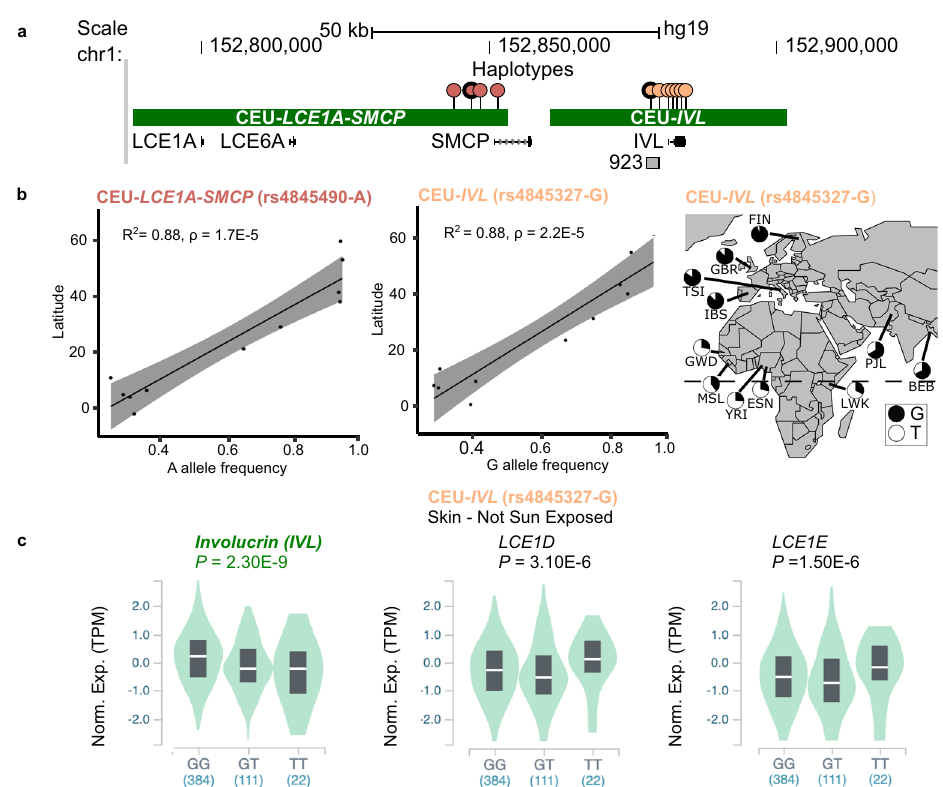
Fig. 2 Selective sweeps for CEU- LCE1A-SMCP and CEU- IVL out-of-Africa. a Phasing reveals CEU- LCE1A-SMCP and CEU- IVL haplotypes (green bars) in CEU based on SNPs in linkage disequilibrium ( r 2 > 0.8) with the high CMS/iSAFE (red; rs12022319, rs4845490 [bolded], rs4845491, & rs3737861) and iSAFE (orange; rs4845327 [bolded], rs1854779, rs7539232, rs11205132, rs2229496, rs7535306, & rs7545520) SNPs (lollipops). CEU- IVL includes IVL and the epidermis-speci fi c 923 enhancer, whereas CEU- LCE1A-SMCP includes LCE1A , LCE6A , and SMCP . b Direct and positive correlations between the frequencies of rs4845490-A & rs4845327-G, and Northern latitudes reveal associations of the CEU- LCE1A-SMCP and CEU- IVL selective sweeps with out- of-Africa migration ( ρ = 1.7E-5 and 2.2E-5), respectively. Black line indicates a linear relationship (Pearson ’ s correlation) between allele frequency and geographic latitude, two-sided t -test (9 degrees of freedom) with gray area surrounding the regression line representing 95% con fi dence intervals for the group mean values of the latitude for each allele frequency. Pie charts of rs4845327-G allele frequency for each population are indicated on the map. c Violin plots for rs4845327-G for CEU- IVL , an eQTL for increased IVL and decreased LCE1D and LCE1E expressions shown in not sun-exposed skin (GTEx [V8]). Box in violin plot represents interquartile range with median (white line). Numbers in parenthesis indicate number of individuals for each genotype. Norm. Exp., normalized expression; TPM, transcripts per million. Chi-Square p -value was calculated based on Mahalanobis distance and Bonferroni